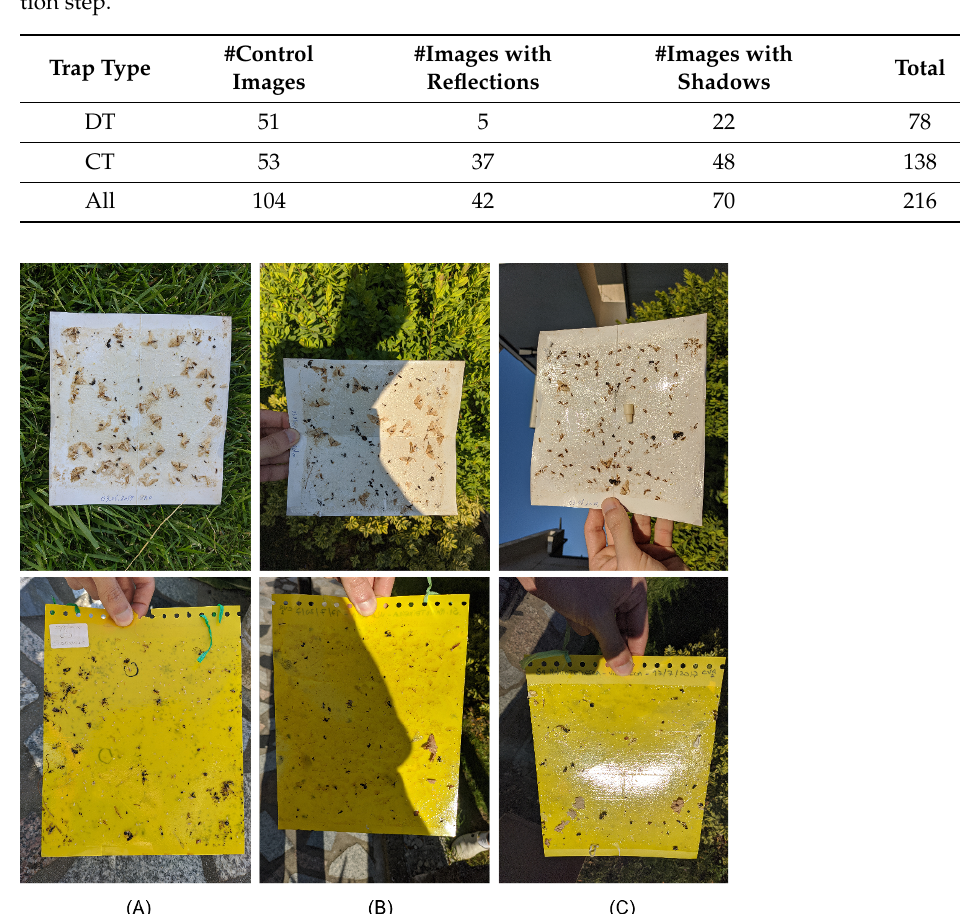
Table 3. Dataset image distribution regarding labelled data for the reflections and shadows valida- tion step.